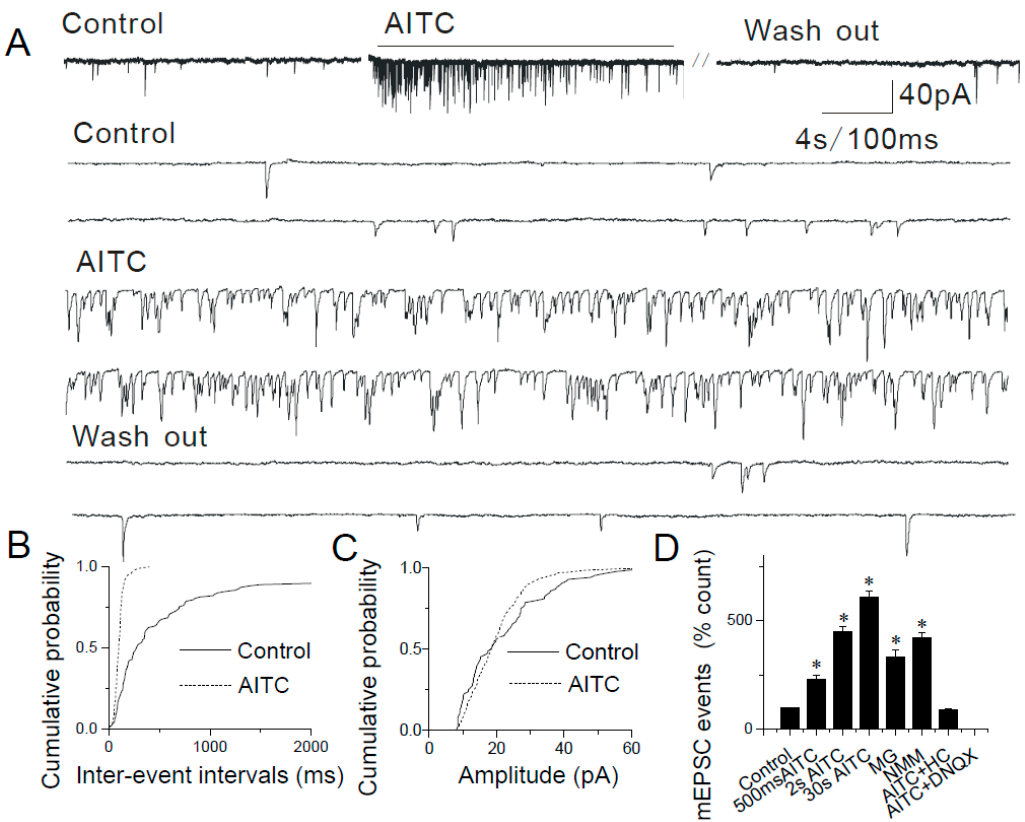
Figure2. ModulationofsynaptictransmissionintheNTSbyallylisothiocyanate(AITC).( A Figure 2. Modulation of synaptic transmission in the NTS by allyl isothiocyanate (AITC). ( A )